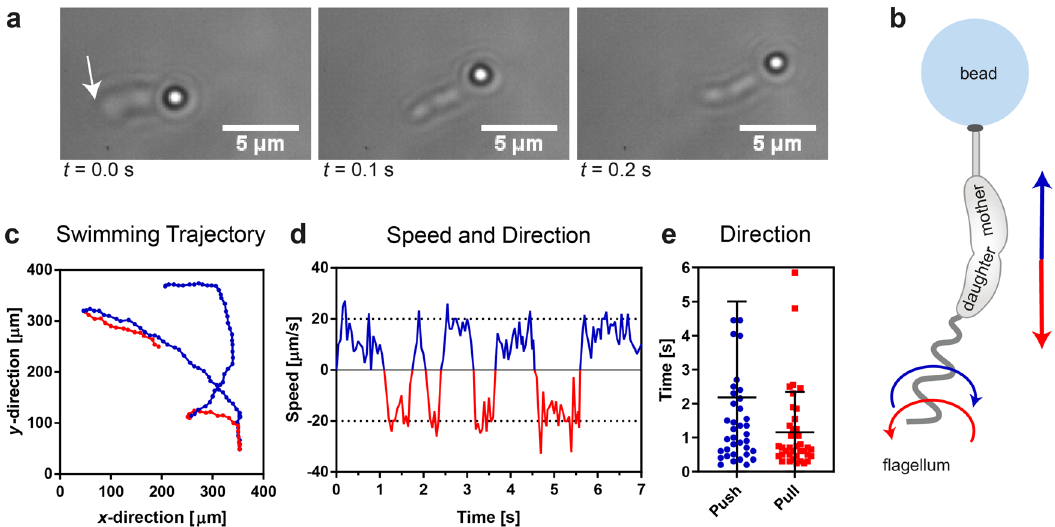
Fig. 1 Swimming predivisional cells attached to a small bead. a Consecutive bright fi eld images of a swimming predivisional WT cell attached to a polystyrene bead with diameter 1 µ m. The arrow indicates the fl agellated pole. b Scheme of the predivisional cells attached to the bead (CW rotation of fl agellum, causing forward swimming: blue. CCW rotation of fl agellum, causing backward swimming: red) c Example trajectory of the swimming bacteria- on-a-bead. Forward swimming: blue, backward swimming: red. d Swimming speed of the cells attached to the bead in a thin microchamber device. Sign of speed values re fl ects swimming sequence: positive for forward swimming (blue) and negative for backward swimming (red). e Average duration of individual forward (push sequence) and backward (pull sequence) swimming sequences ( N = 3, 39 measurements per direction, error bars represent ± standard deviation